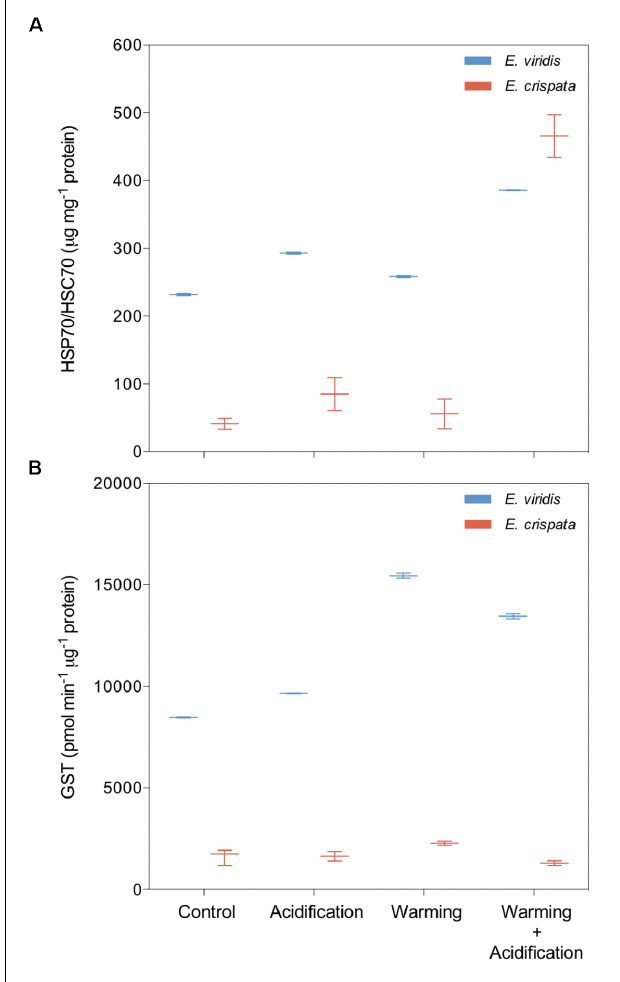
FIGURE 5 | Effects of ocean warming and acidification on the heat shock response (HSP) and antioxidant defense (GST) of tropical E. crispata and the temperate E. viridis . (A) HSP and (B) GST, under different climate change scenarios, i.e., control (18 and 26 ◦ C, pH8.0); acidification (18 and 26 ◦ C, pH7.6); warming (22 and 30 ◦ C, pH8.0) and acidification + warming (22 and 30 ◦ C, pH7.6) experimental treatments. Tukey box-plots show median, percentile 25th and 75th, and – 1.5 times IQR and + 1.5 times IQR,